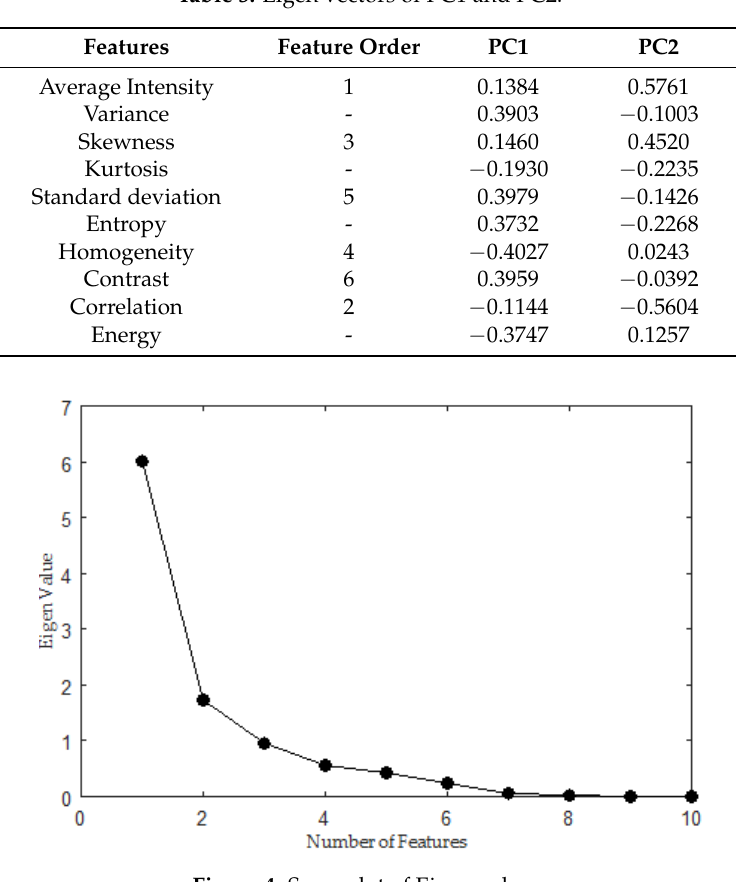
Figure 4. Scree plot of Eigen values.